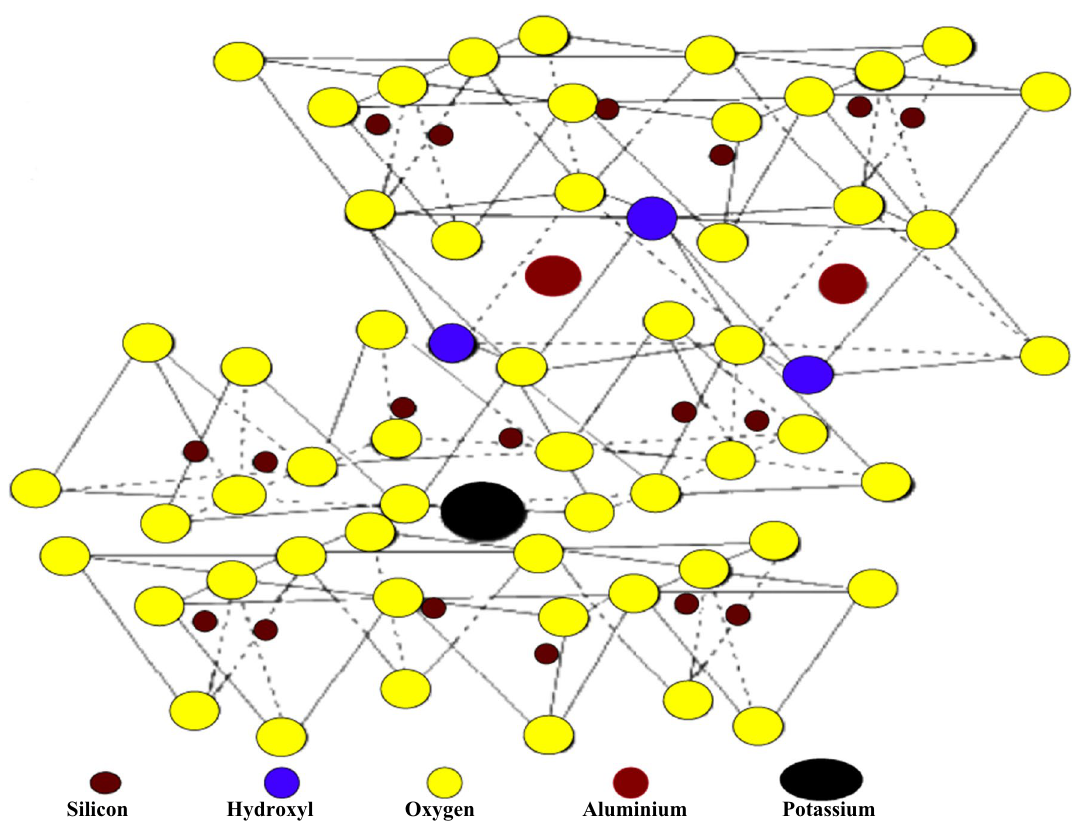
Fig. 18 Structure of